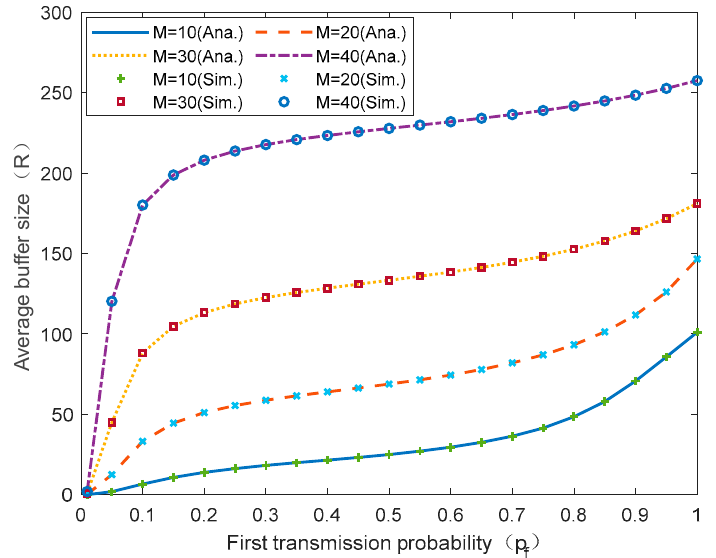
Figure 12. Buffer size vs. first transmission probability (Ana. vs. Sim.).